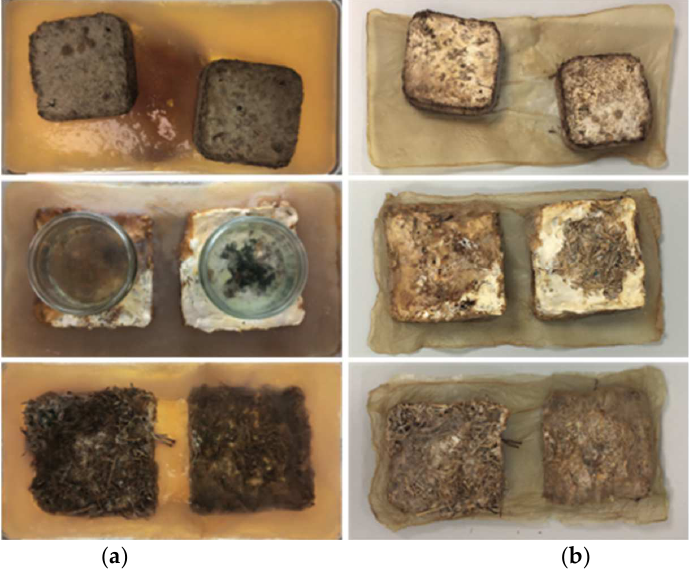
Figure 7. Comparison of experiments 1–3 in the order oven-dried, air-dried, and living from top to bottom in ( a ) wet state and ( b ) dried state (image credit: authors).